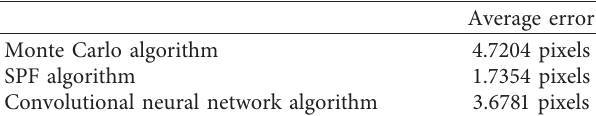
Table 2: Average error